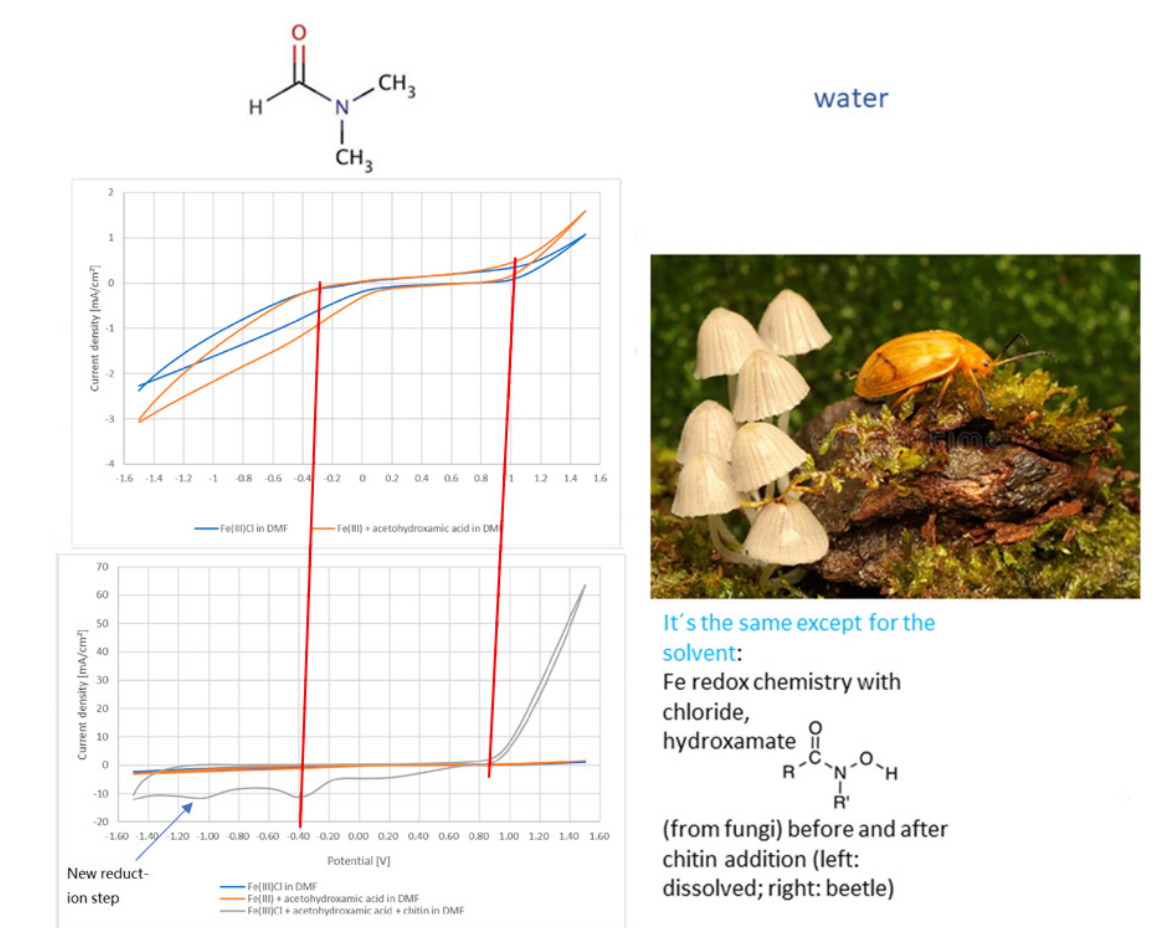
Figure 9. Derivation of chitin adsorption free energies of metal complexes which are likely to occur in soils from electrochemical data. Note that a new reductive peak turns up upon chitin adsorption of (probably Cl − -containing Fe hydroxamatocomplex) at − 1.1 V vs. SCE. The lines are inclined to the left, indicating an (uneven) depression of redox potential (determined by CV) upon adsorption to chitin, meaning that the Fe(III) complex (which is very stable in the case of Fe(III) [43]) more strongly adsorbs to chitin than its Fe(II) counterpart. For the CV diagrams, cp. [12]. Picture taken from a conference contribution by S.F.